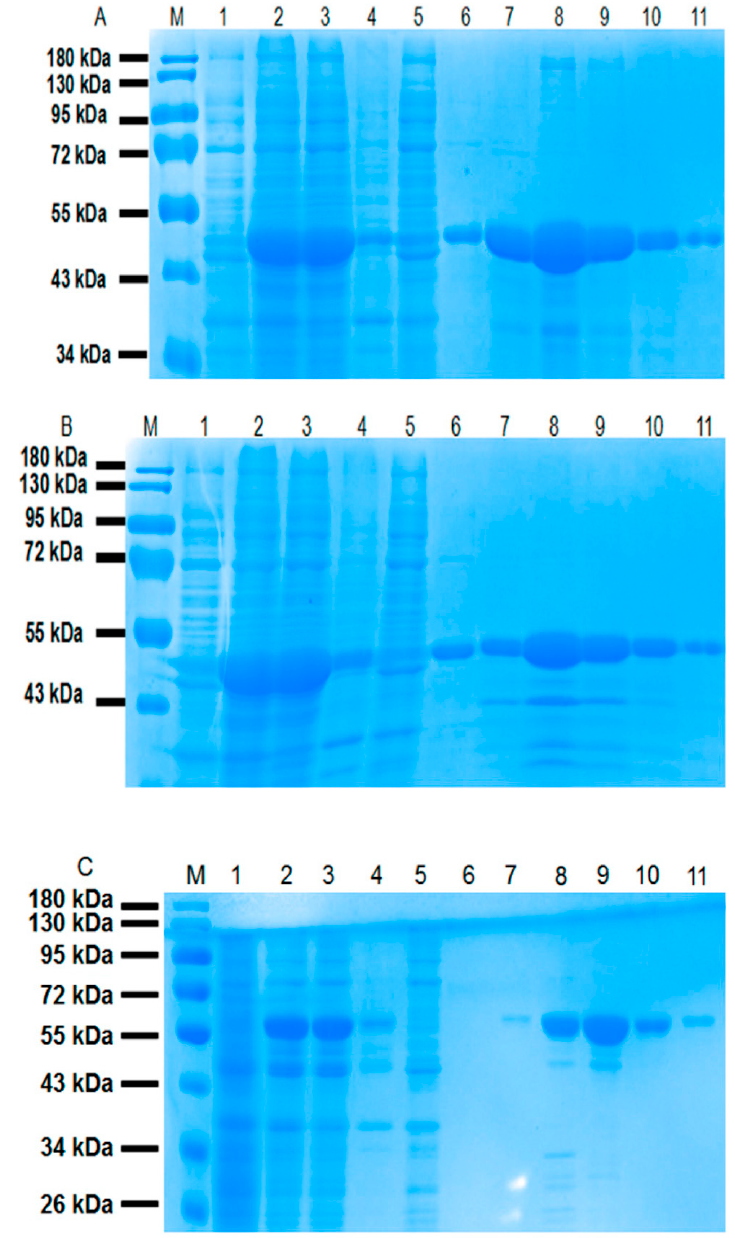
Figure 3. SDS-PAGE analysis of the ( A ) CL7-sfGFP, ( B ) CL7-mCherry and ( C ) CL7-huArg I fusion proteins purified by Ni-NTA. M: protein ladder (Thermo Scientific, Product# 26616); Lane 1: E. coli cells without IPTG (Isopropyl β - d -Thiogalactoside); Lane 2: E. coli cells induced with 1 mM IPTG; Lane 3: supernatant after sonication; Lane 4: debris after centrifugation; Lane 5: flow-through of supernatant after binding with Ni 2 + -resin; Lane 6: flow-through of Ni 2 + -resin washed with 20 mM imidazole; Lane 7 to Lane 10: elution of 4mL TBS (tris-bu ff ered saline) containing 50 mM, 100 mM, 150 mM and 200 mM imidazole, respectively; Lane 11: the resin resuspended in 4 mL